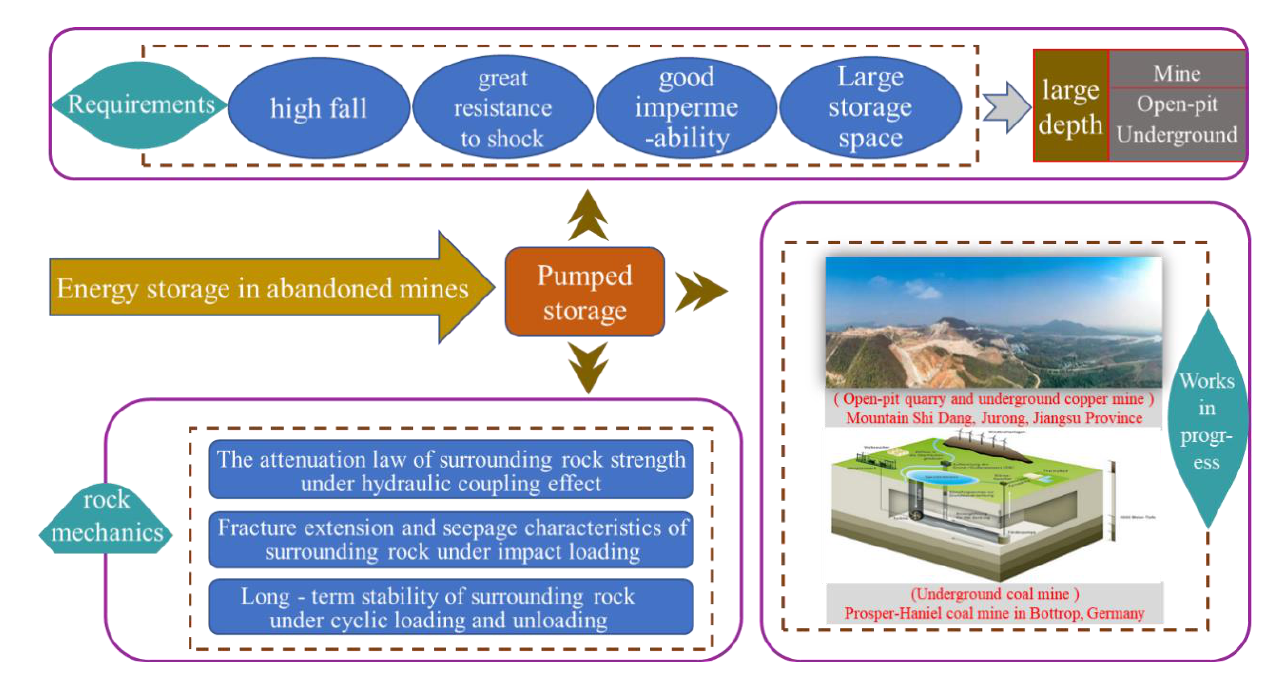
Figure 11. Construction requirements and rock mechanics of abandoned mine PHS plants.